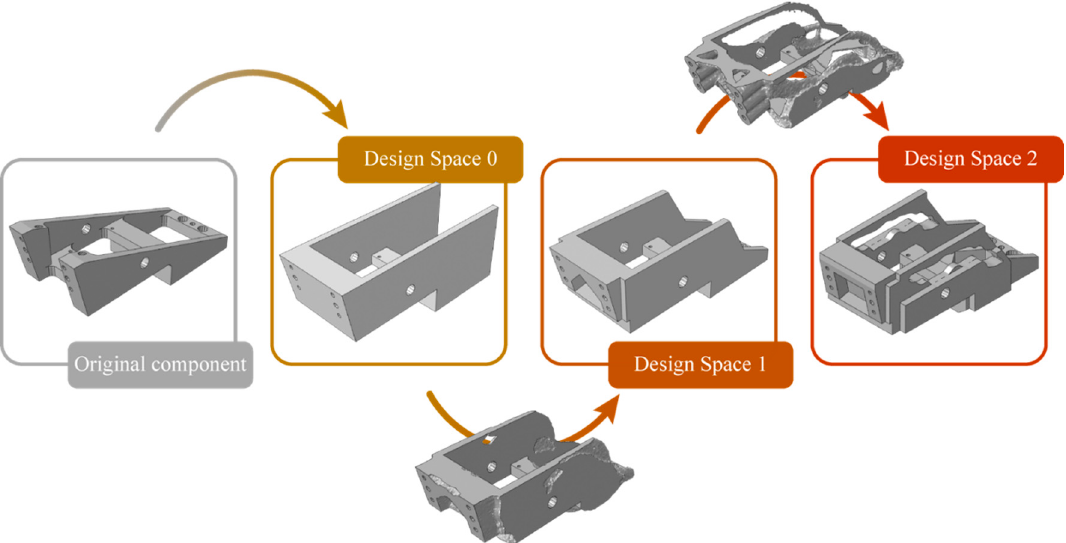
Figure 9. Iterations of the design space optimization. At each iteration, the material has been removed from the area at low energy deformation and has been added in the ones at high energy deformation. The iterations ended when the maximum displacement of the bracket under the load was less than the prescribed requirement (20 µm).